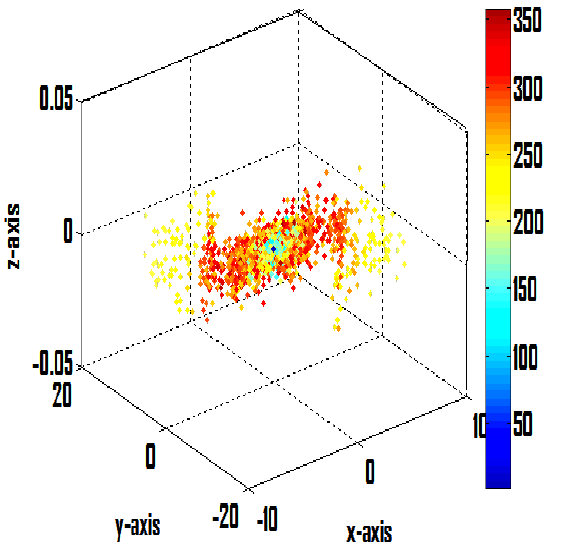
Fig.8: Velocity distributions in x-y plane of the spiral hot disk model after 322.9 million